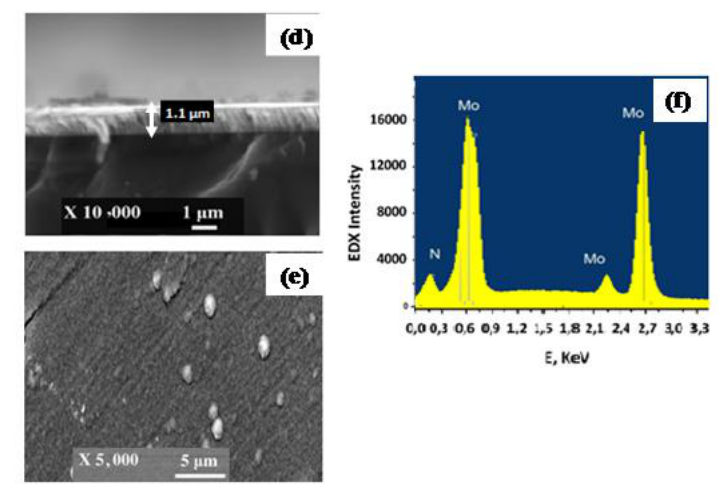
Fig. 7. SEM images of the MoN films: a, d) sectional view b, e), surface view of the coating, and c, f) EDX spectrum of MoN film deposited at 150 to 120